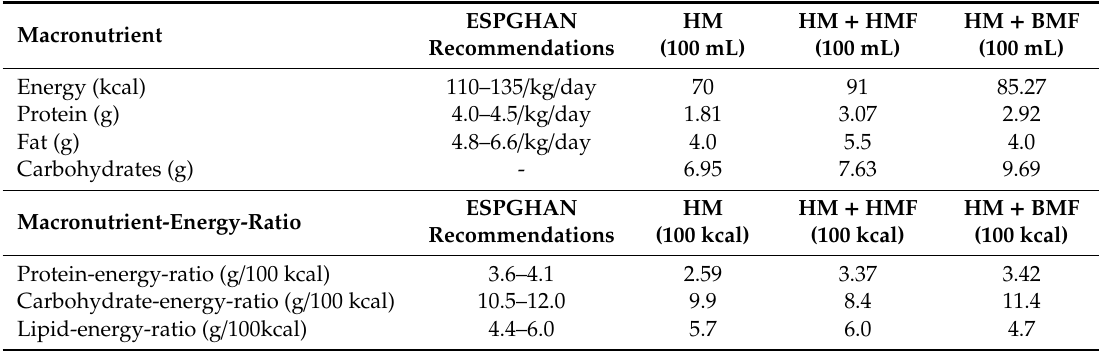
Table 1. ESPGHAN (European Society for Pediatric Gastroenterology, Hepatology and Nutrition) Recommdations [1] for macronutrient intake for infants with a birthweight < 1500 g, macronutrient content of human milk (HM), HM + human milk based fortifier (HMF), and HM + bovine based fortifier